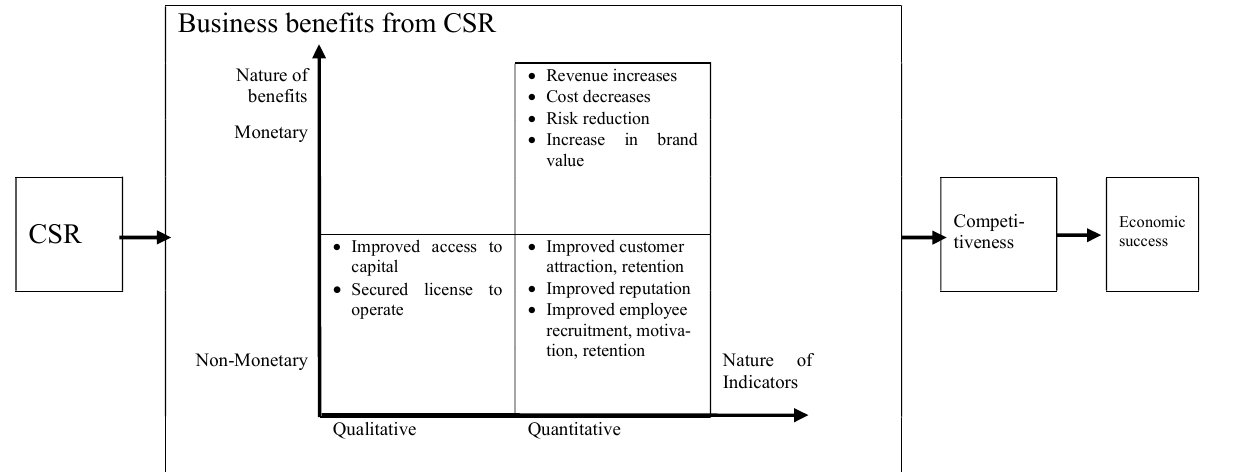
Fig. 2. Social responsibility’s benefits characteristics and nature diagram by Weber's